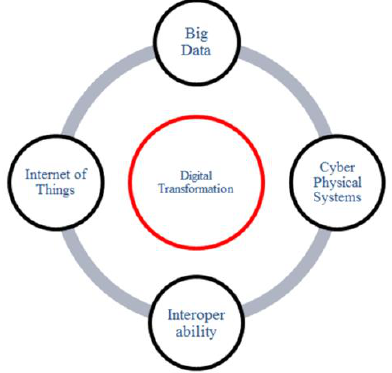
Figure 3. Factors of digital transformation